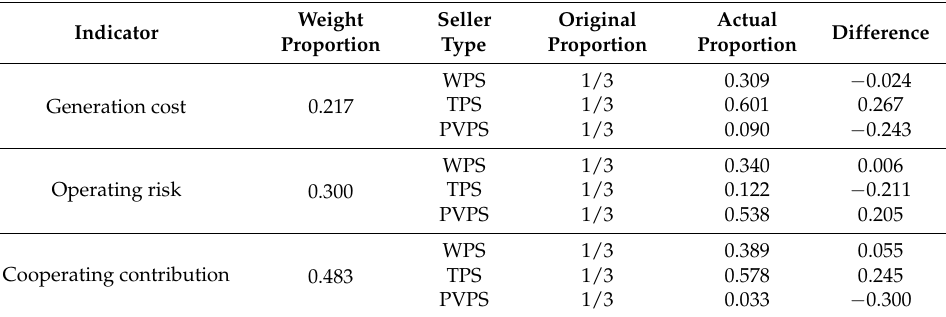
Table 8. Actual basic weight